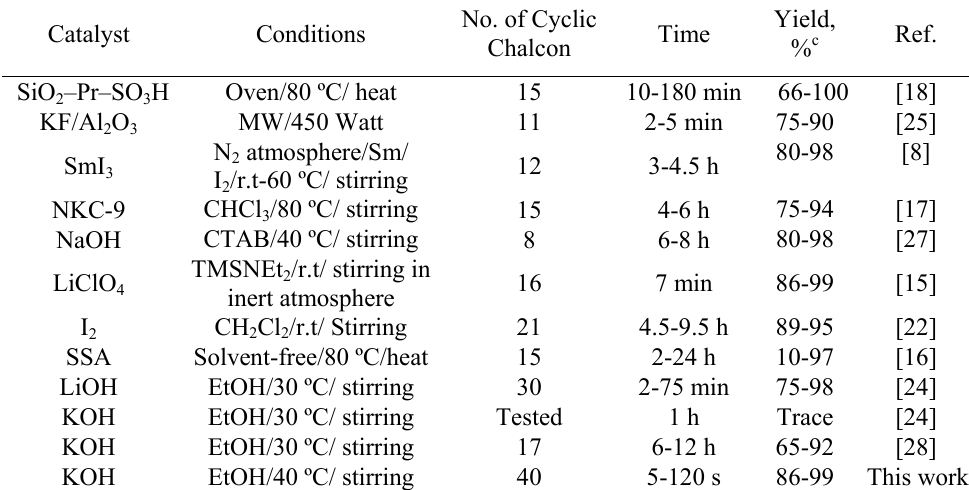
Table 1. Comparison of our results with results obtained by other groups Catalyst